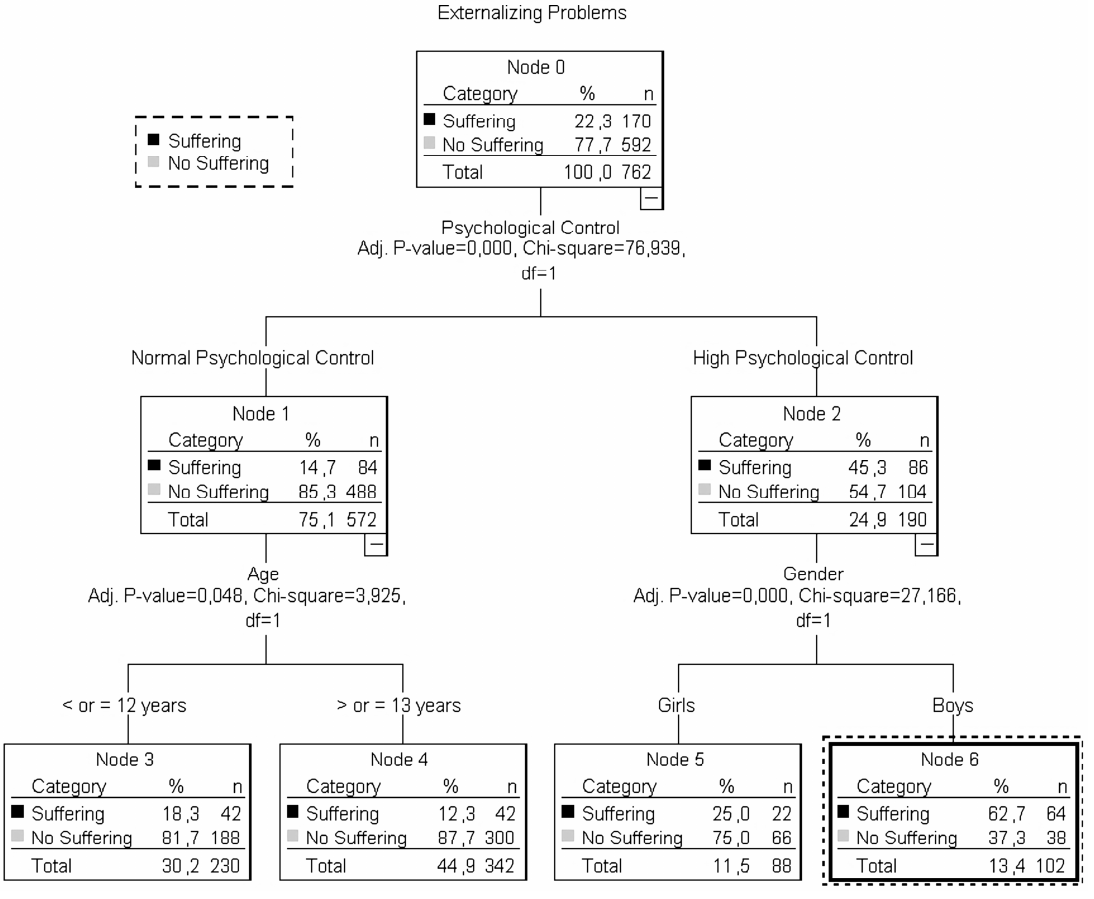
Figure 1. Classification tree for externalizing problems.